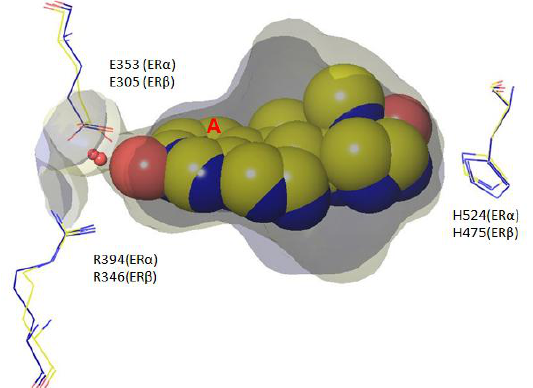
Figure 8. The binding of E2 in the pocket of ERα (PDB ID: 1GWR, yellow) and ERβ (PDB ID: 3OLL, blue), which are more or less comparable in size and volume. The phenolic A ring binds tightly to the pocket forming a triumvirate hydrogen bond network with a crystallographic water (red sphere), E353/305 (ERα/ERβ) and R294/246(ERα/ERβ) while the D ring forms a single hyrdrogen bond with H524/475 (ERα/ERβ). Apart from the A ring, the rest of the E2 molecule possesses high conformational